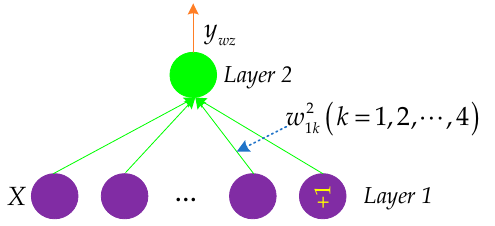
Figure 7. The structure of deep neural network used in overload subsystem.